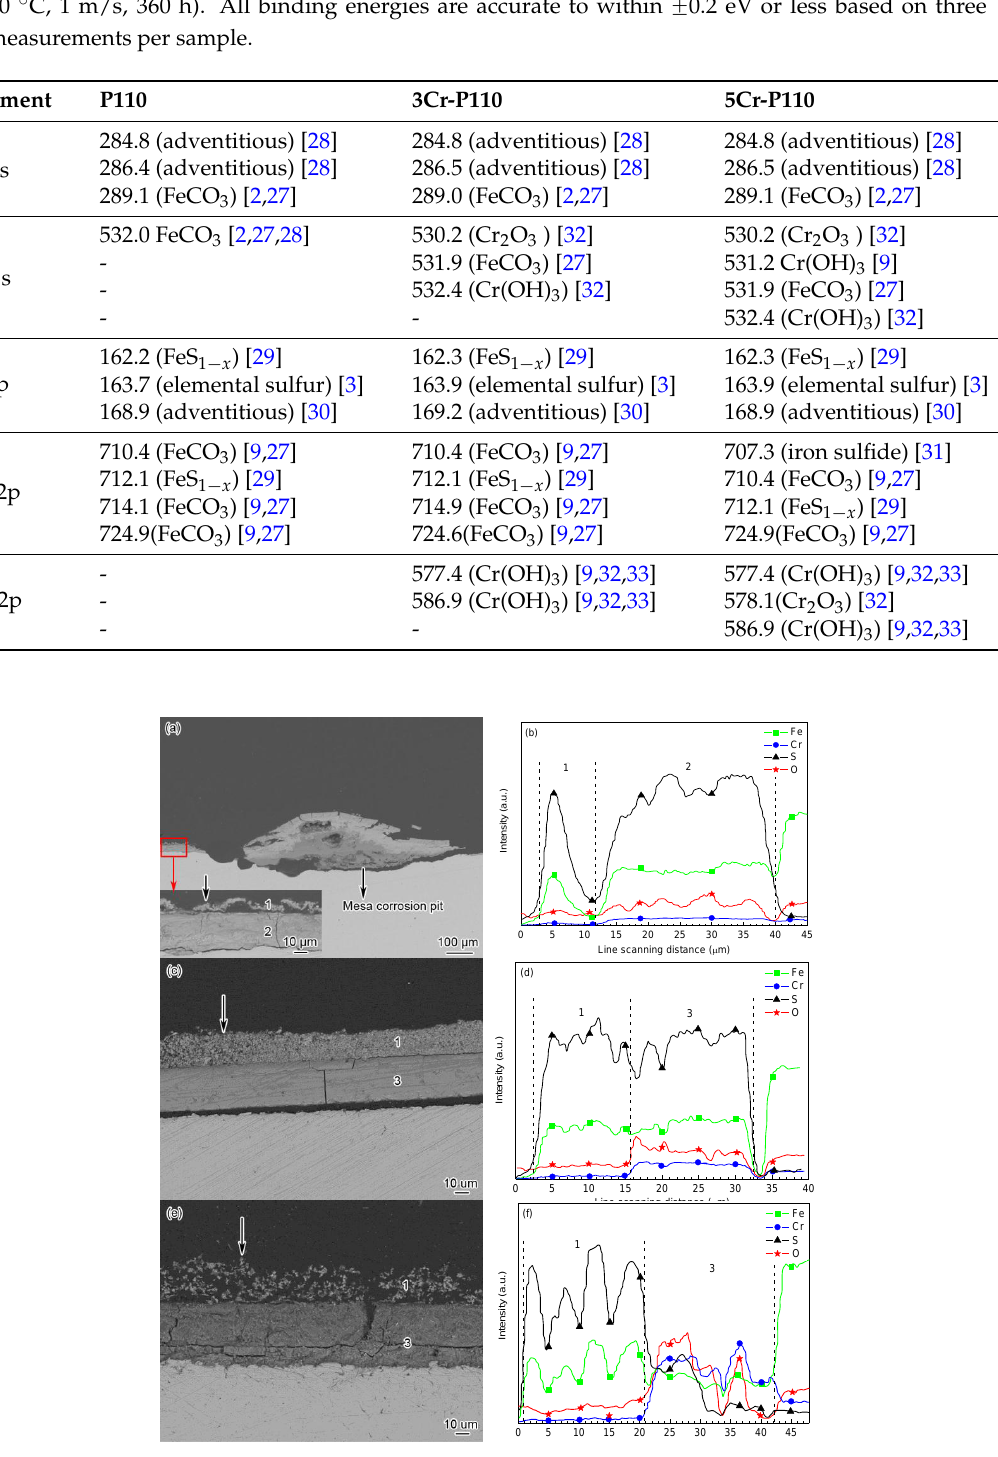
= 5 MPa, P H = 0.2 MPa, 2 2 S